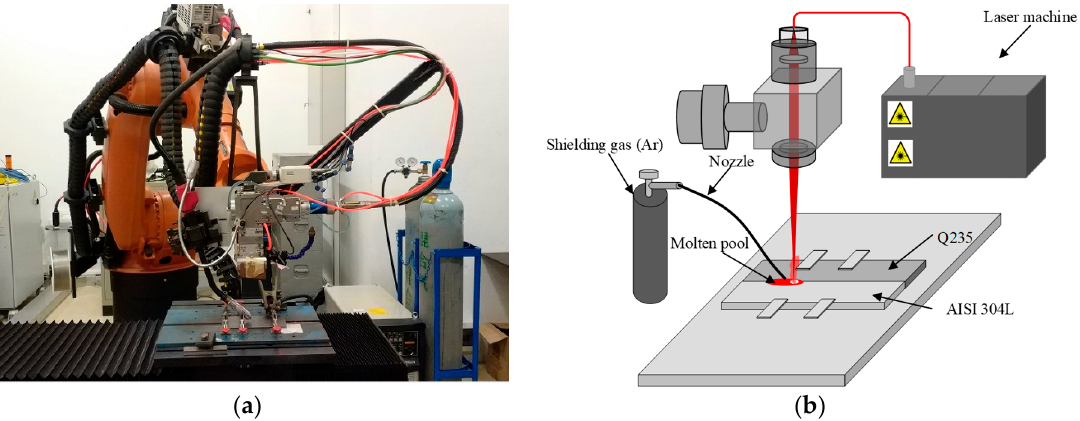
Figure 1. The experimental setup and a schematic of the laser welding system. ( a ) Experimental setup; ( b ) The schematic of the laser welding system.